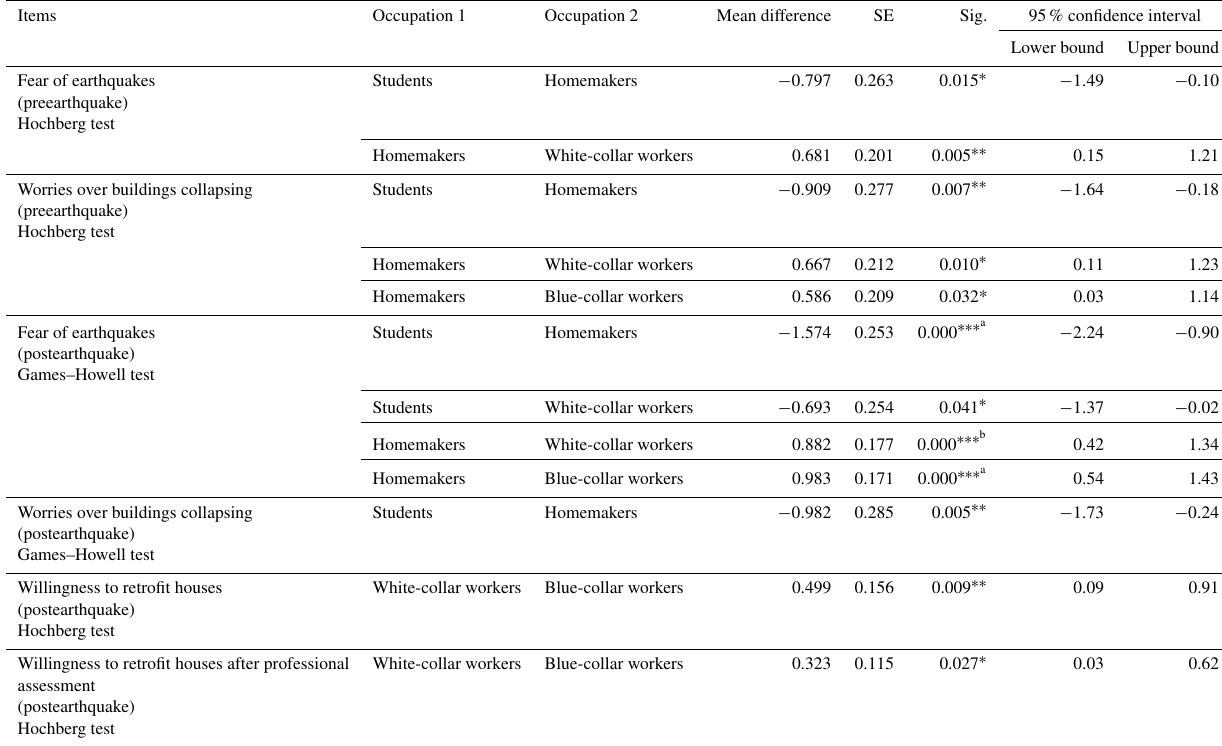
Table 8. Post hoc results for occupation (for the categories compared across the two occupation columns. Items